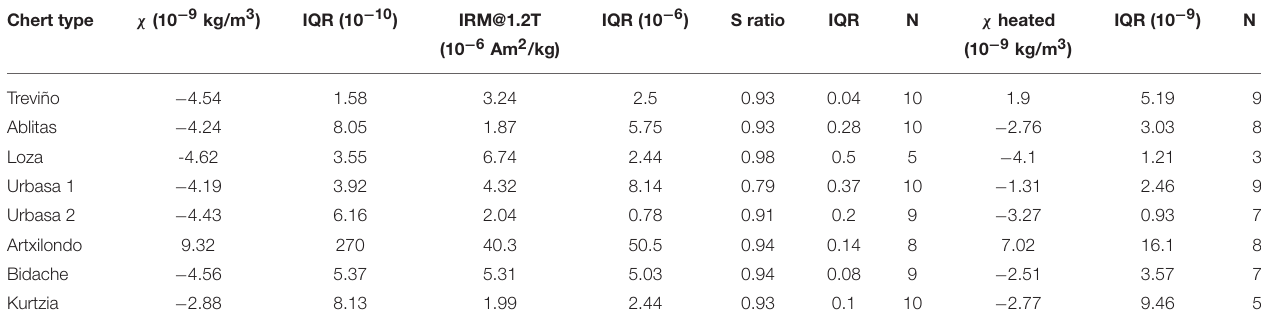
TABLE 1 | Median values and associated interquartile ranges (IQR) for magnetic properties of BCB chert types measured in this study. Chert